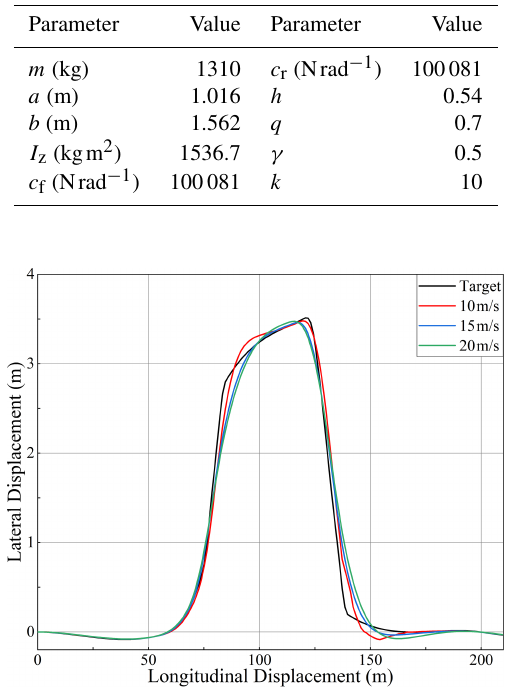
Figure 9. Trajectory tracking at different speeds.